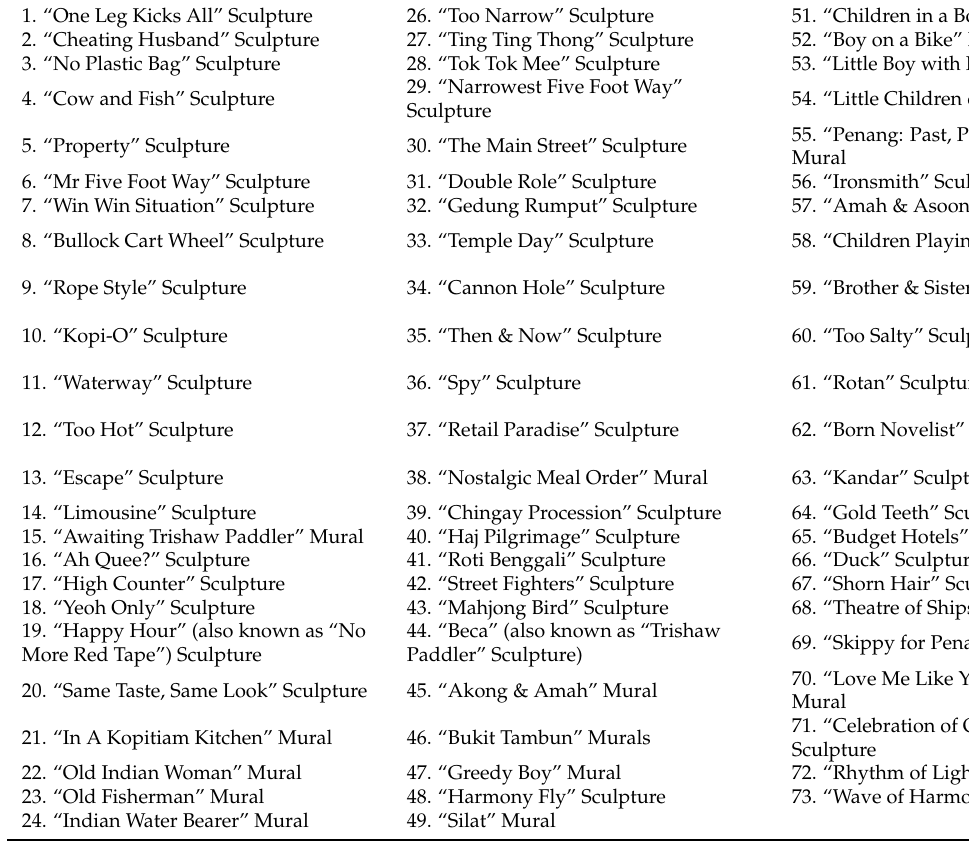
Table 1. List of Street Art in George Town,